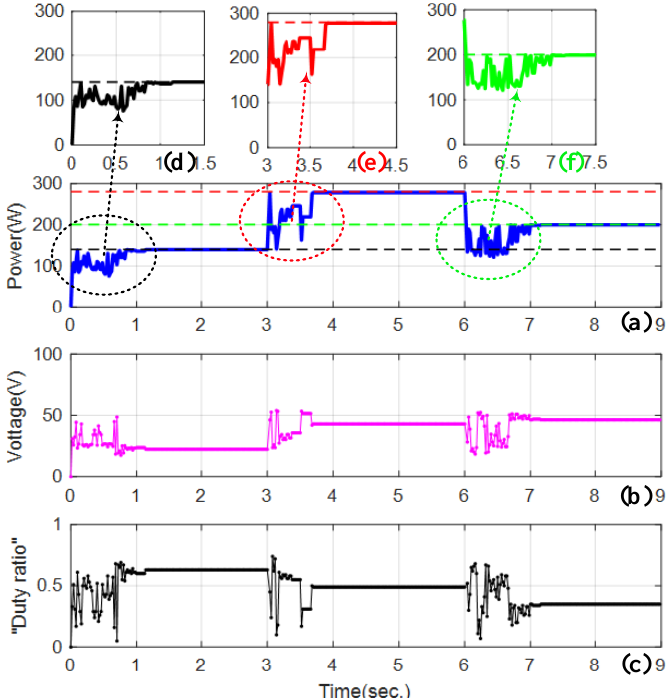
Figure 11. Results of the PSO method for two serial panels. ( a ) PV power, ( b ) PV voltage, ( c ) duty ratio, and ( d – f ) transient trajectories for situations 1 – 3, respectively. (Black --, red --, green --: global maximum values of situations 1 – 3).